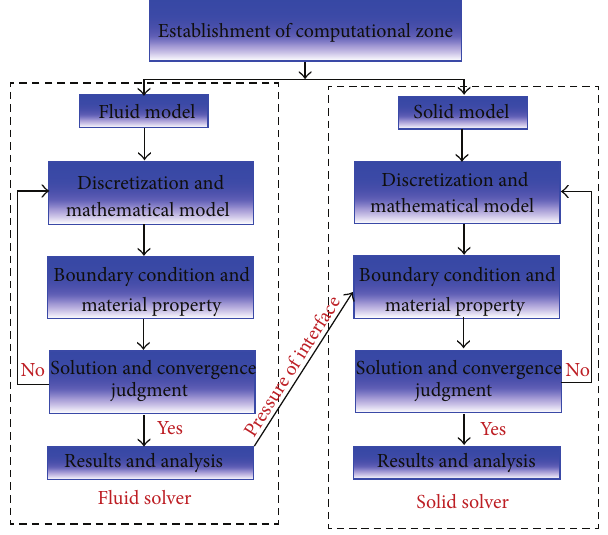
Figure 6: Calculation principle process based on Workbench.